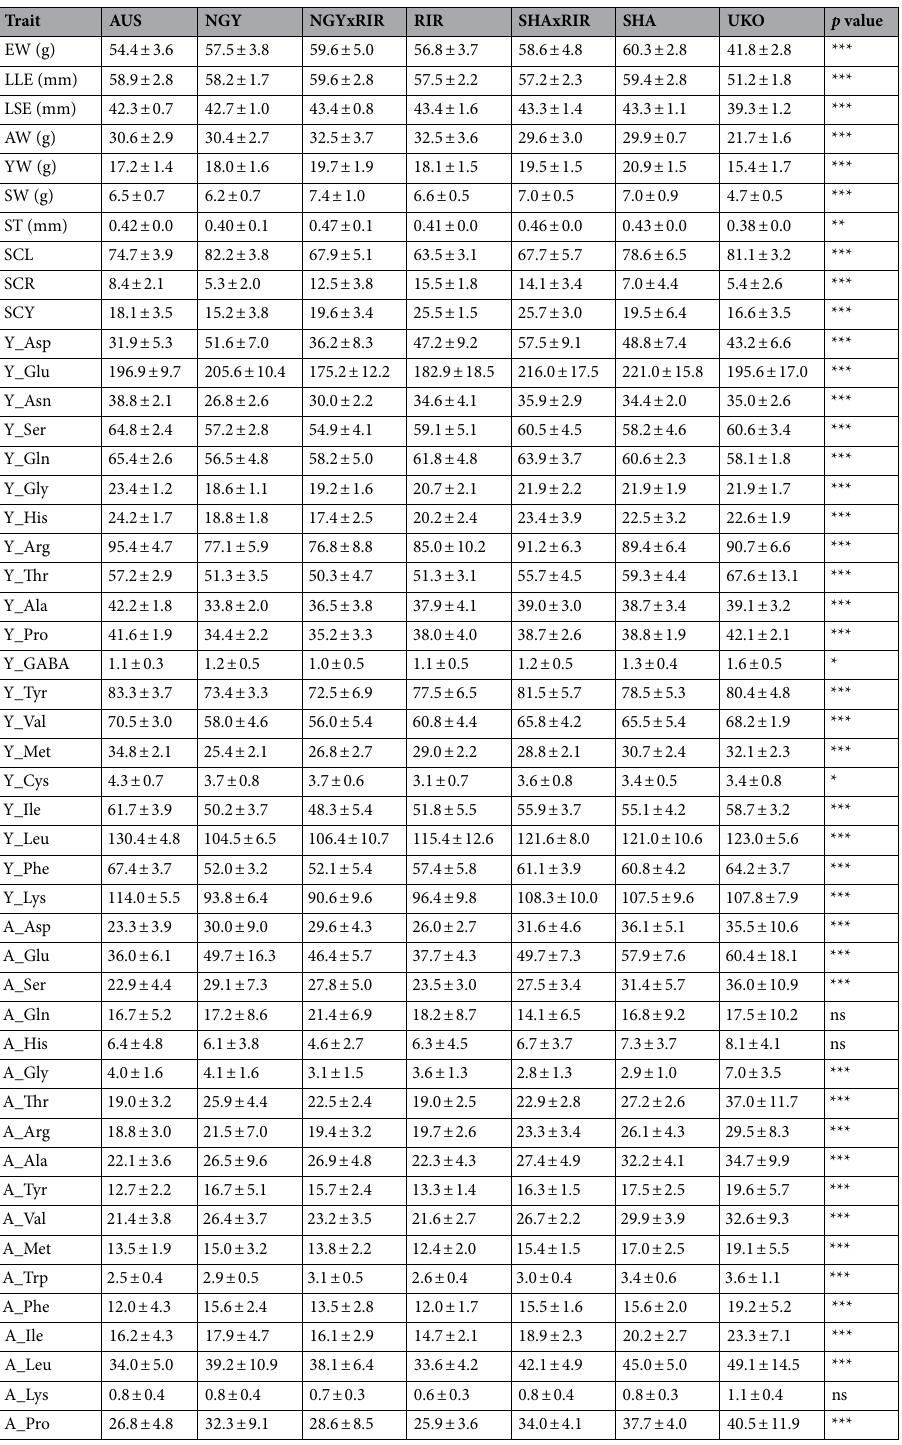
Table 1. All egg traits and amino acid traits in five breeds and two F 1 hybrids of chickens. Trait abbreviations were shown in methods. Amino acid concentrations were shown in µg/mL. p value from one-way ANOVA is shown as *** p < 0.001, ** p < 0.01, * p < 0.05, and ns p > 0.05. Mean ± SD. Results of Tukey’s HSD tests were shown in Figures S1,S2, and